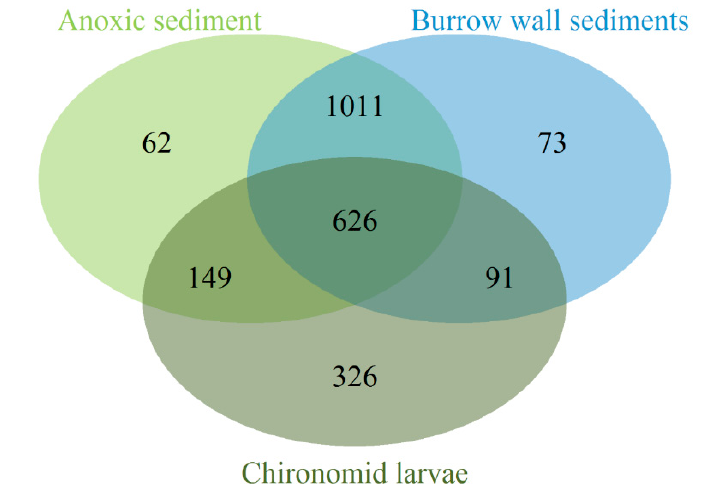
Figure 4. Venn diagram showing the numbers of unique and shared operational taxonomic units (OTUs) in anoxic sediment, burrow wall sediment and chironomid larvae samples (OTU numbers are indicated in the corresponding cross-sections of the diagram).